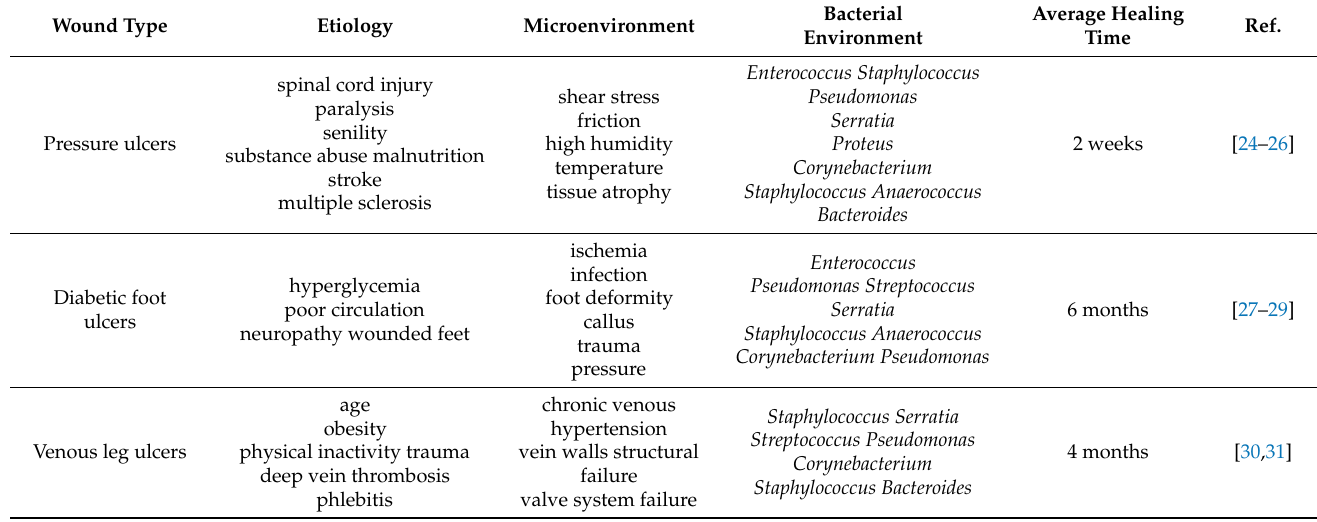
Table 1. Types of chronic wounds and its main